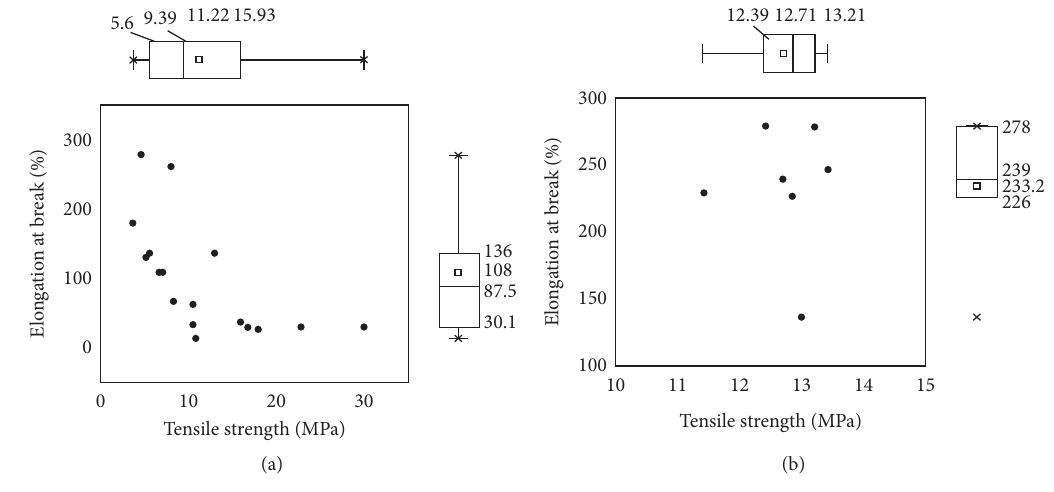
Figure 8: Tensile properties: (a) epoxy resin; (b)